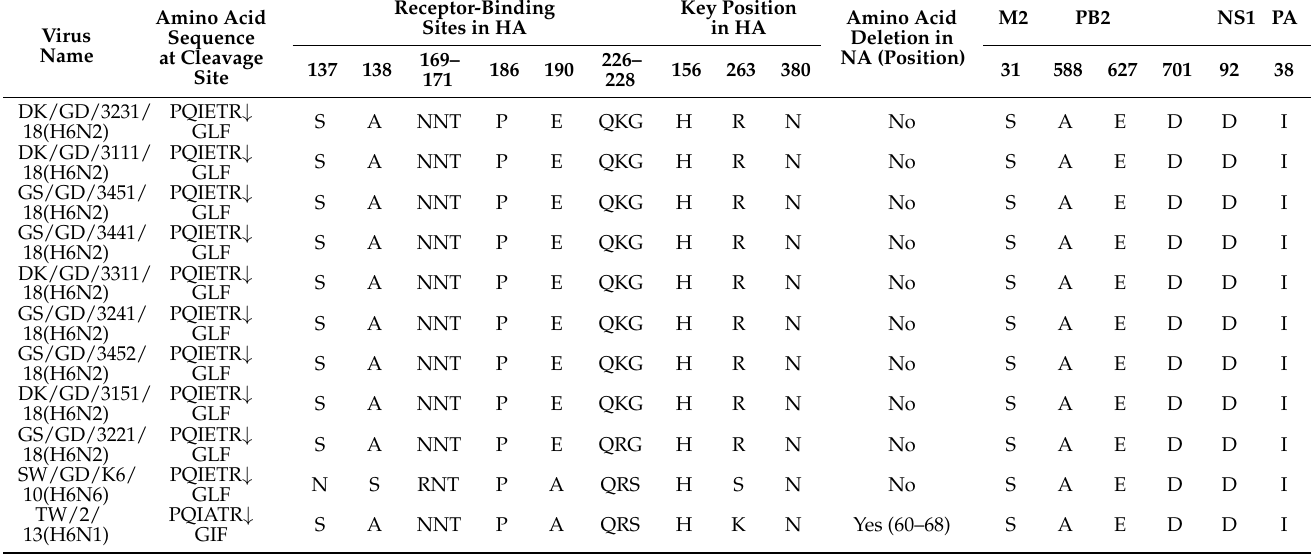
Table 2. Molecular characterization of H6Nx influenza viruses in China. DK, duck; GS, goose; SW, swine; TW, Taiwan; GD,